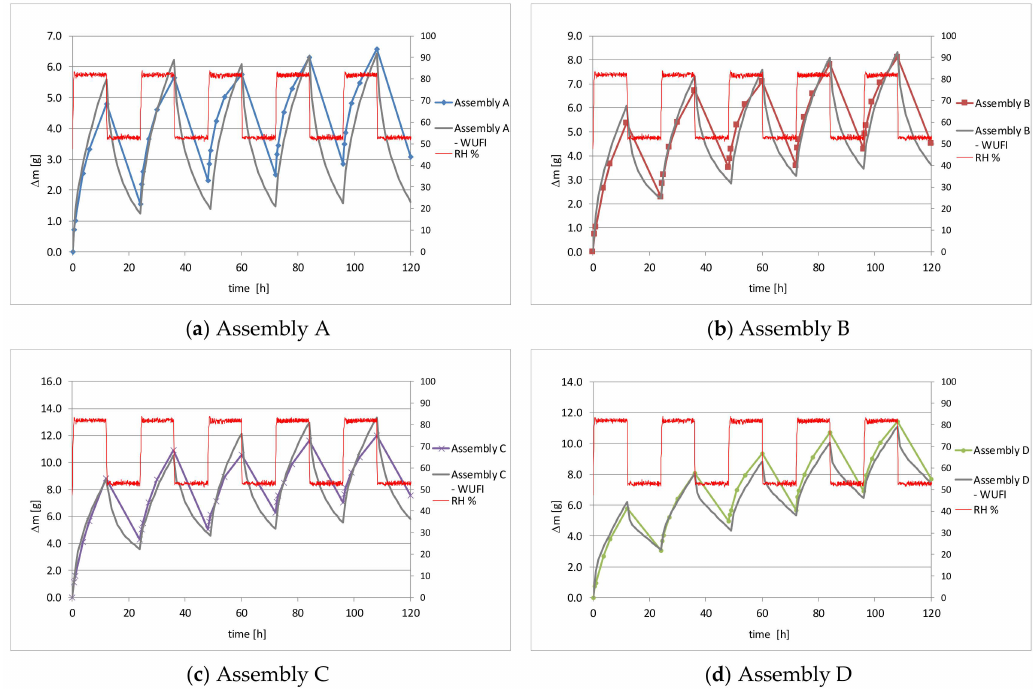
Figure 9. Comparisons of the numerical and experimental data, showing the change in mass of individual assemblies over five 24-h cycles: ( a ) Assembly A; ( b ) Assembly B; ( c ) Assembly C; ( d ) Assembly